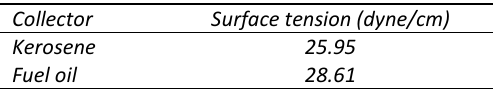
Surface tensions of Classical Oils